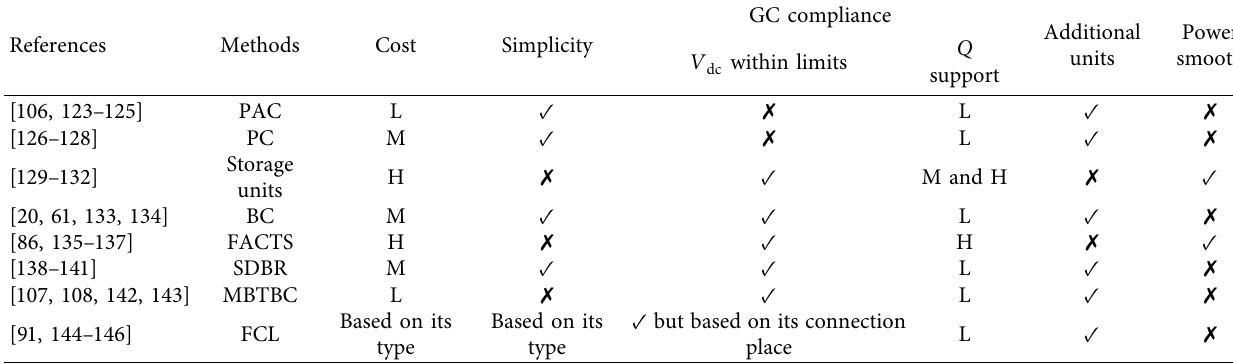
Table 6: Comparative of implemented diferent FRTC